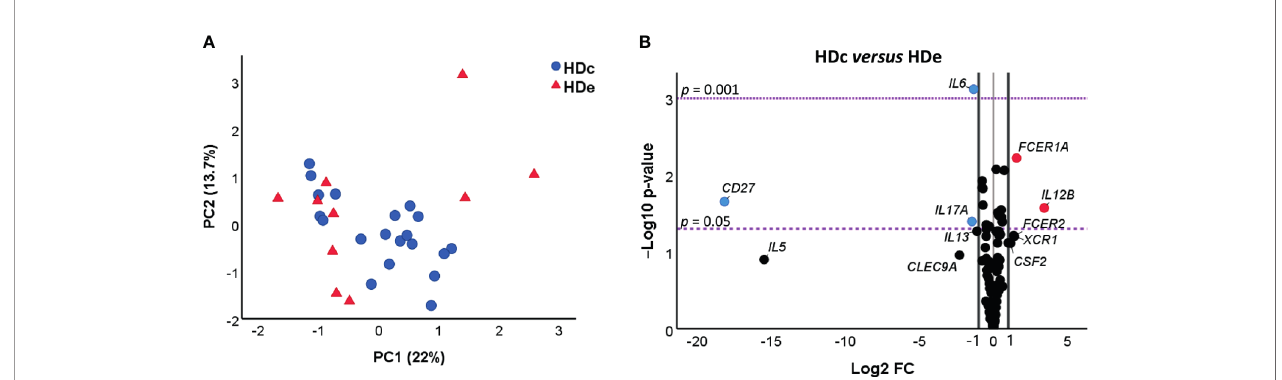
FIGURE 1 | Comparative analysis of gene expression of 106 genes in healthy donors from non-endemic (HDc, n = 20) and endemic (HDe, n = 10) areas of Chagas disease. (A) Principal component analysis (PCA) of NRQ (normalized relative quantities) values of gene expression of 106 analyzed genes in HDc (blue circles) and HDe (red triangles). Principal components 1 (PC1) and 2 (PC2) are plotted on the x and y axes, respectively, and the proportion of variance captured for both components is given as a percentage. (B) Volcano plot of the differential expression level of the 106 analyzed genes between samples of HDc and HDe subjects. The x-axis represents log 2 of the expression fold change between HDc and HDe (Log 2 FC), where FC is calculated as the ratio between two groups (HDc/HDe). The y-axis corresponds to the statistical signi fi cance, expressed as the negative logarithm of the p -value (-Log 10 p -value). The purple horizontal lines indicate the cutoffs for the statistical signi fi cance values p = 0.05 and p = 0.001. The black vertical lines represent the log 2 of FC of − 1 and 1 (corresponding to FC of 0.5 and 2, respectively) which were used as biological thresholds to identify differentially expressed genes. The negative values correspond to downregulated genes (blue dots) and the positive values to the upregulated genes (red dots). Black dots comprising between the established thresholds represent non-differentially expressed genes between HDc and